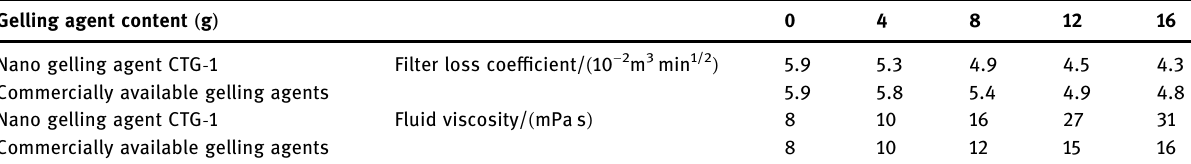
Gelling agent content ( g )